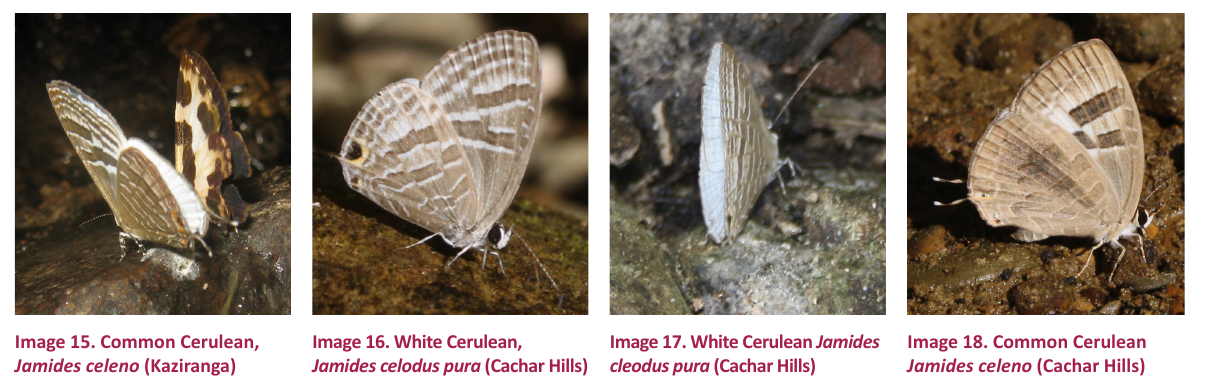
Image 14. White Cerulean Jamides cleodus pura (Kaziranga) upperside